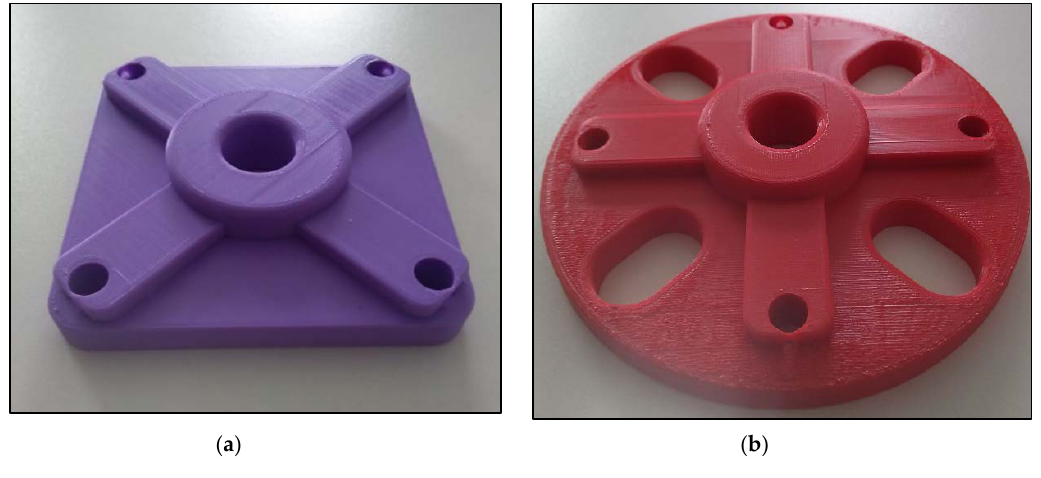
Figure 13. Builds for test cases 1 ( a ) and 2 (b ).